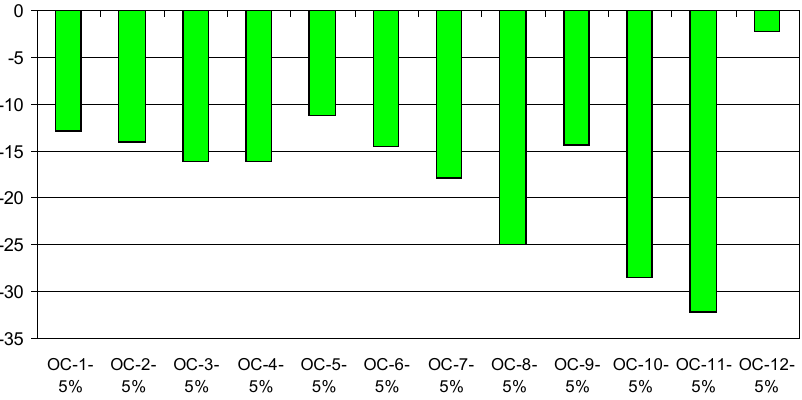
Figure 4. Percentage changes of PM emissions over the NEDC from a test car with fuels containing individual oxygenates at a concentration of 5% v / v compared to running on conventional diesel fuel.